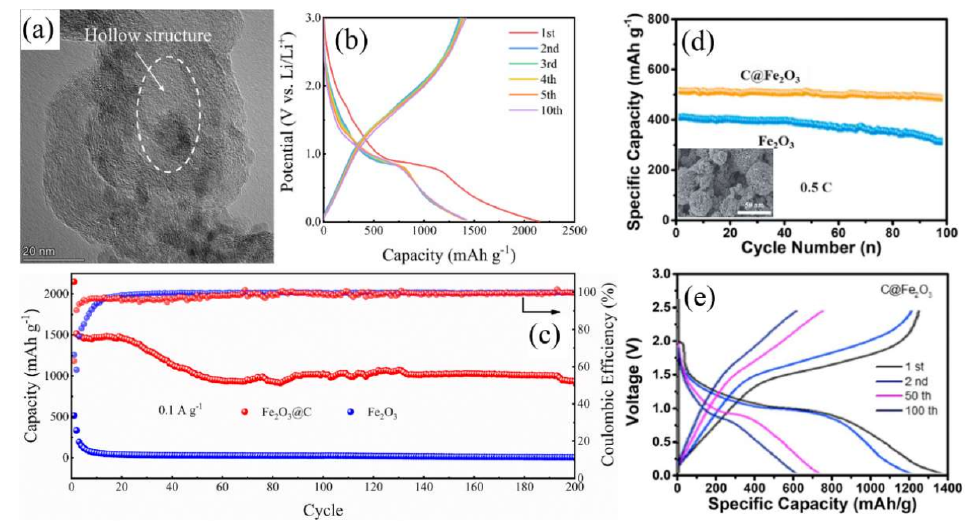
Figure 3. ( a ) Transmission electron microscopy (TEM) image of Fe 2 O 3 @C composite, highlighting its local hollow structure [14]. The scale bar is 20 nm. ( b ) Galvanostatic voltage profiles of discharge– charge for some selected cycles of Fe 2 O 3 @C composite obtained between 0.01 V and 3.00 V vs. Li + /Li at 0.1 A g − 1 [14]. ( c ) Comparison of capacities and Coulombic efficiencies of Fe 2 O 3 and Fe 2 O 3 @C, respectively, cycled at 0.1 A g − 1 over 200 galvanostatic cycles [14]. ( d ) Capacity retention over 100 cycles for hierarchical C@Fe 2 O 3 hybrid structure and pure Fe 2 O 3 [45] cycled at 0.5 C, respectively. The inset shows a scanning electron microscopy (SEM) of the hierarchical C@Fe 2 O 3 hybrid structure and its scale bar is 50 nm. ( e ) Galvanostatic discharge–charge curves for a number of selected cycles for the hierarchical C@Fe 2 O 3 hybrid structure cycled between 0.01 and 2.50 vs. Li + /Li at 0.1 C [45]. Reprinted with permission from Ref. [14]. Copyright 2022 Elsevier. and Ref. [45]. Copyright